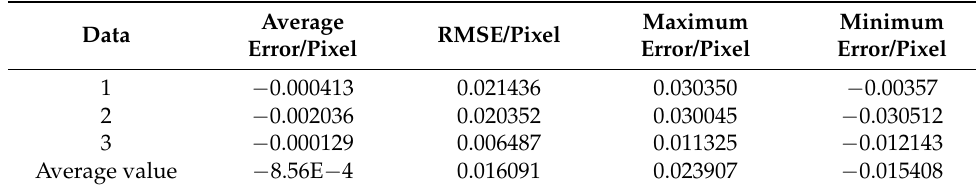
Table 7. Accuracy evaluation results of jitter modeling of three different frequencies by sequential disparity maps. Maximum Minimum Average RMSE/Pixel Data Error/Pixel Error/Pixel Error/Pixel 1 − 0.000413 0.021436 0.030350 − 0.00357 − 0.002036 0.020352 0.030045 − 0.030512 − 0.000129 0.006487